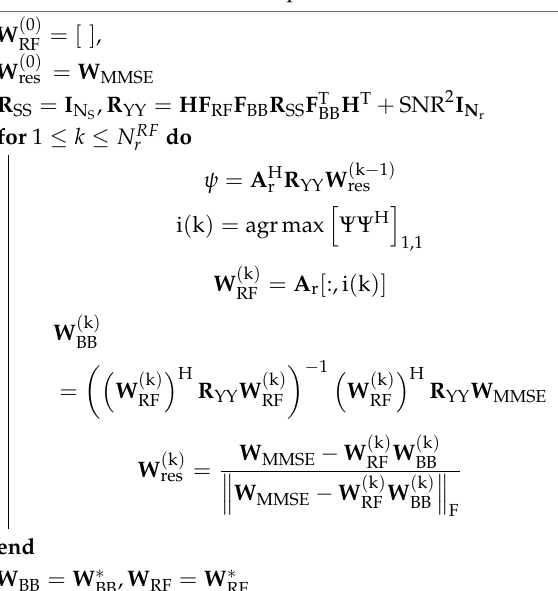
Algorithm 2. Proposed Extended SOMP Algorithm: